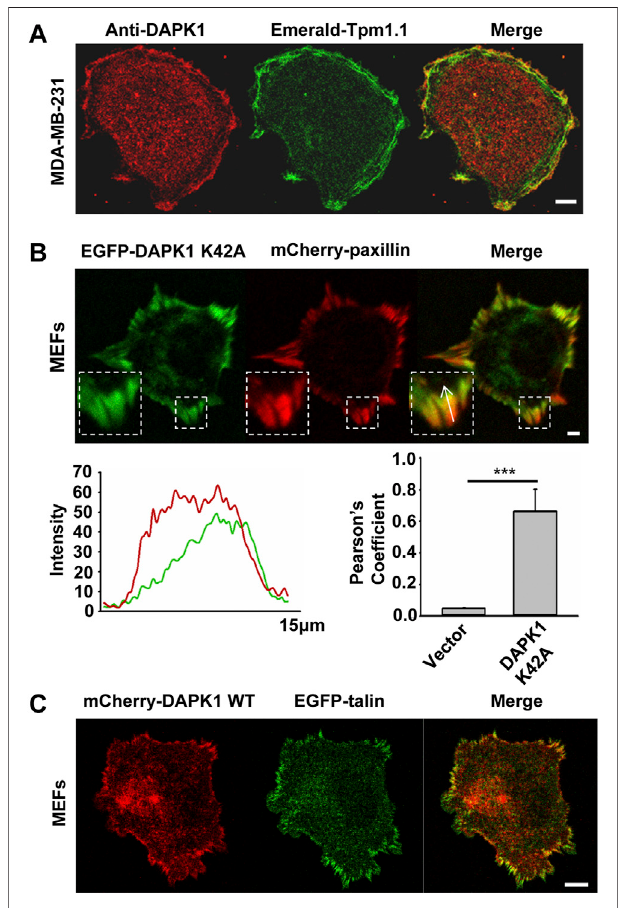
FIGURE 3 | DAPK1 co-localizes with tropomyosin1 and targets to focal adhesion sites. (A) MDA-MB-231 cells were transfected with Emerald- Tpm1.1 WT. Cells were further analyzed by anti-DAPK1/ AlexaFluor555 immunostaining. Scale bar: 10 μ m. (B) Total internal re fl ection fl uorescence (TIRF) image of MEF co-transfected with EGFP- DAPK1 K42A and mCherry-paxillin after 30 min spreading on fi bronectin- coated glass dish. Scale bar: 10 μ m. Fluorescence intensity line pro fi les are from the area of the representative adhesions covered by the white arrow in the merged images. Pearson coef fi cients with Image J were calculated to determine the colocalization of DAPK1 to paxillin-stained adhesions. Data are means ± SEM for 10 individual cells. *** p < 0.001. (C) Representative images of MEFs co-transfected with EGFP-talin and mCherry-DAPK1 WT that were fi xed after 30 min of spreading on fi bronectin-coated glass dish. Scale bar: 10 μ m.